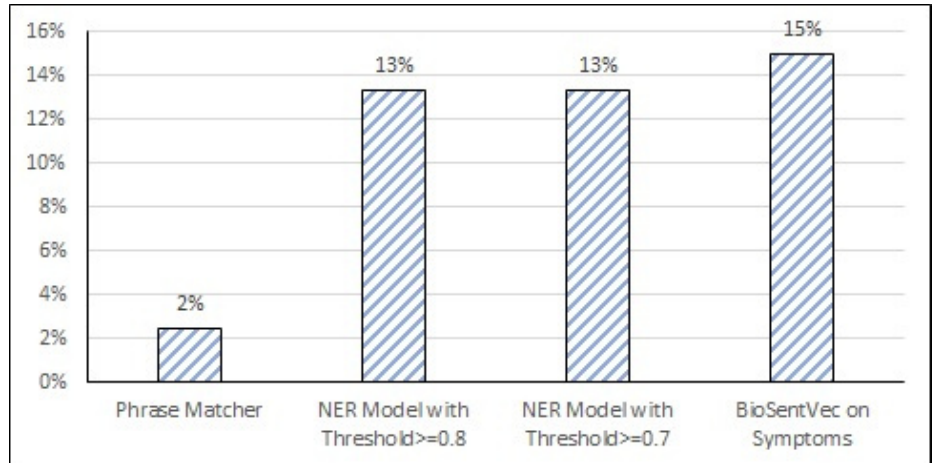
Figure 11. Chart showing the percentage of scraped symptoms interlinked with symptom ontology using different adopted methodologies.